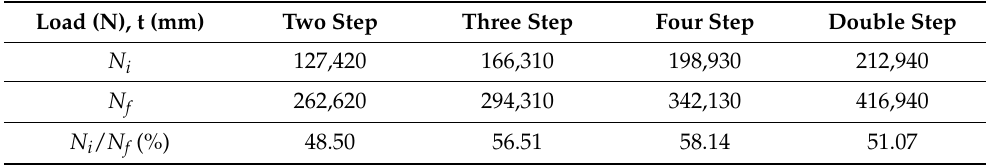
Table 2. N i and N f and their ratios ( N i /N f ) in percentage for various step ‐ lap joints. Load (N), t Two Step Three Step Four Step Double Step (mm)